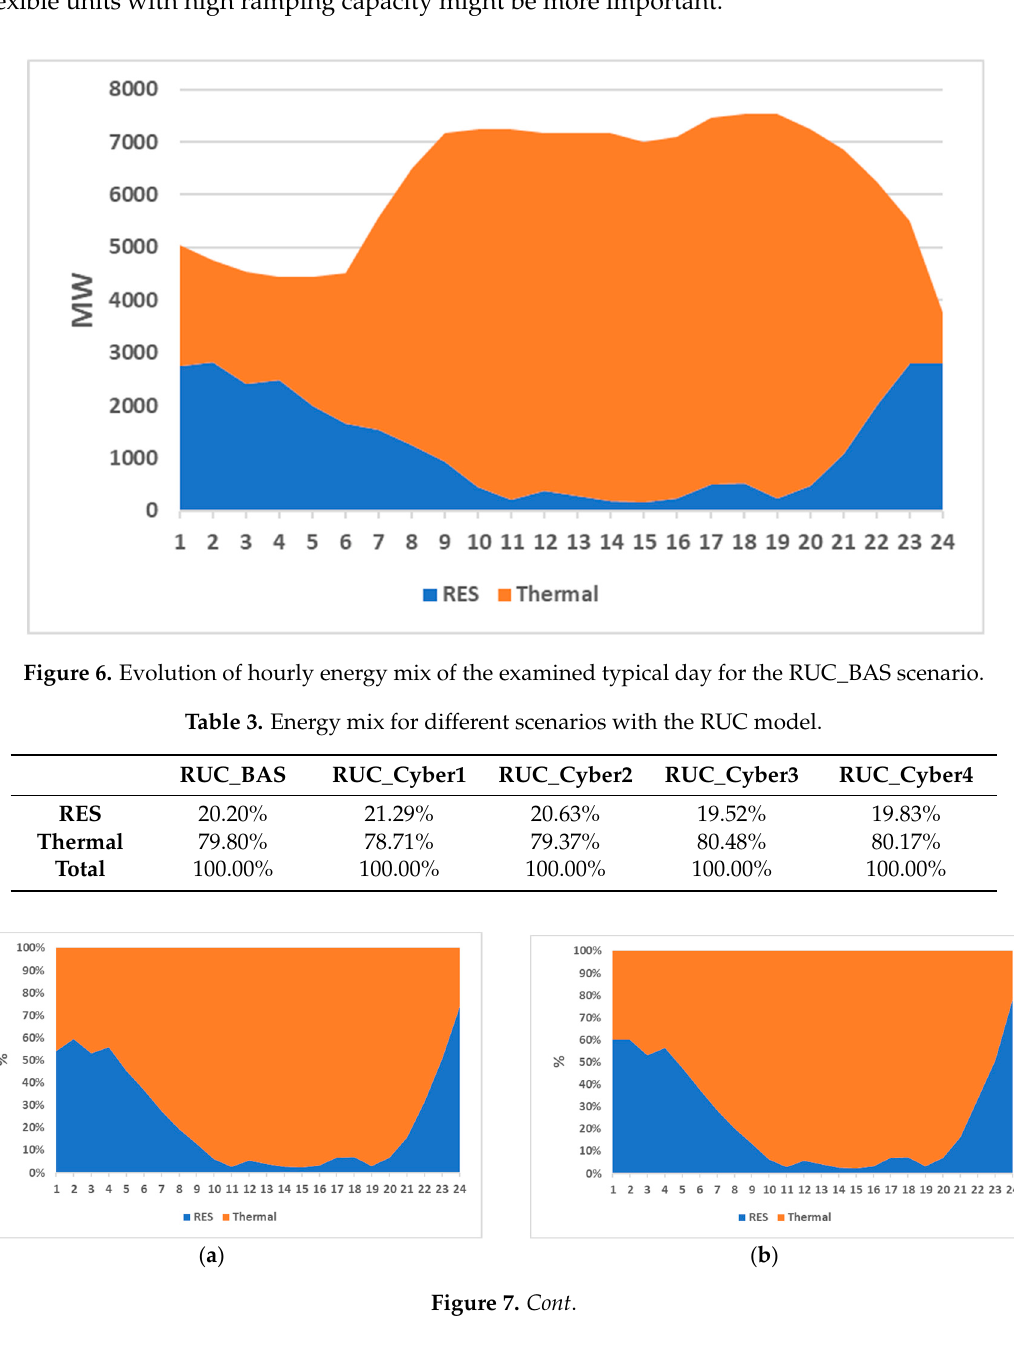
Table 3. Energy mix for different scenarios with the RUC model. 410